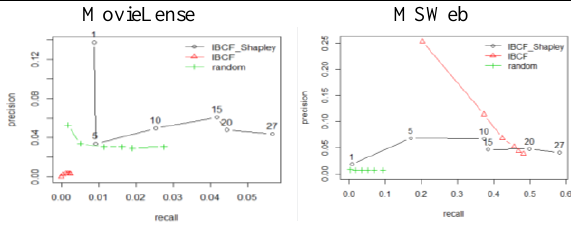
Figure 5. Recision/Recall of three models with k=25